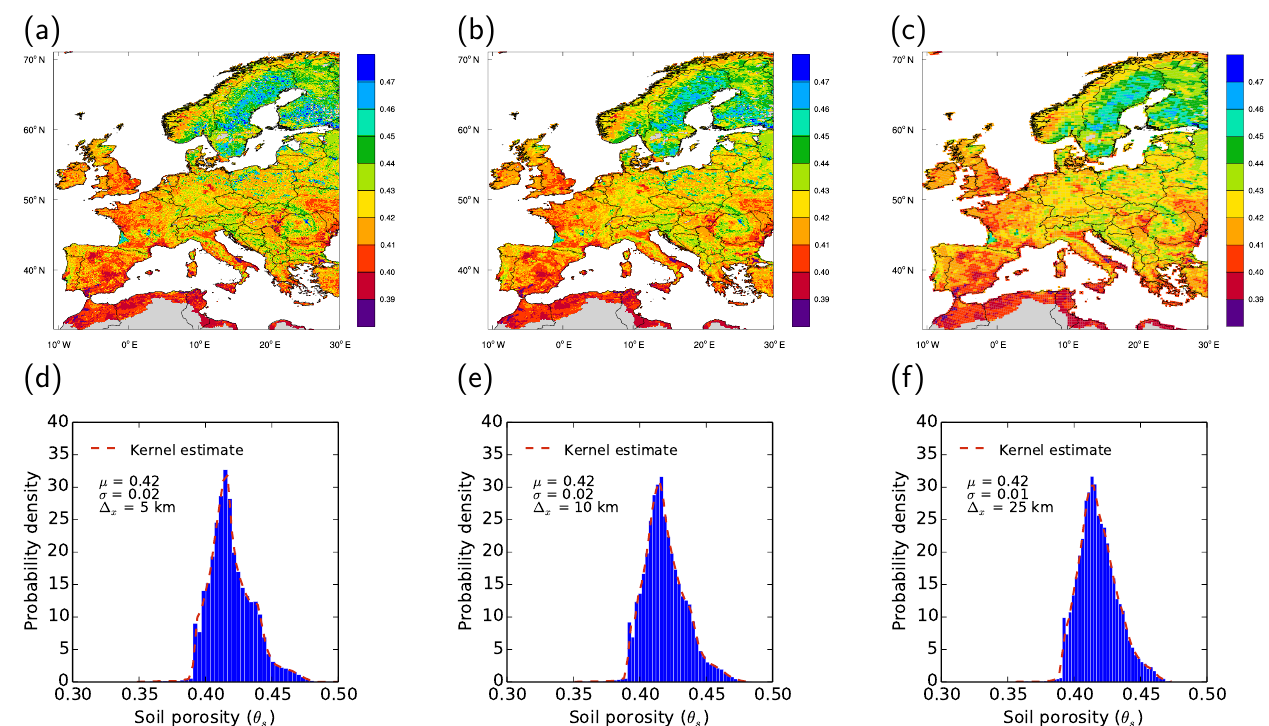
Figure 3. Seamless soil porosity (top 2m) fields obtained using MPR at three spatial resolutions (cid:96) 1 : (a) 5km, (b) 10km, and (c) 25km, respectively. Lower panels (d) – (f) show the empirical distribution function of porosity at the respective resolution and method.